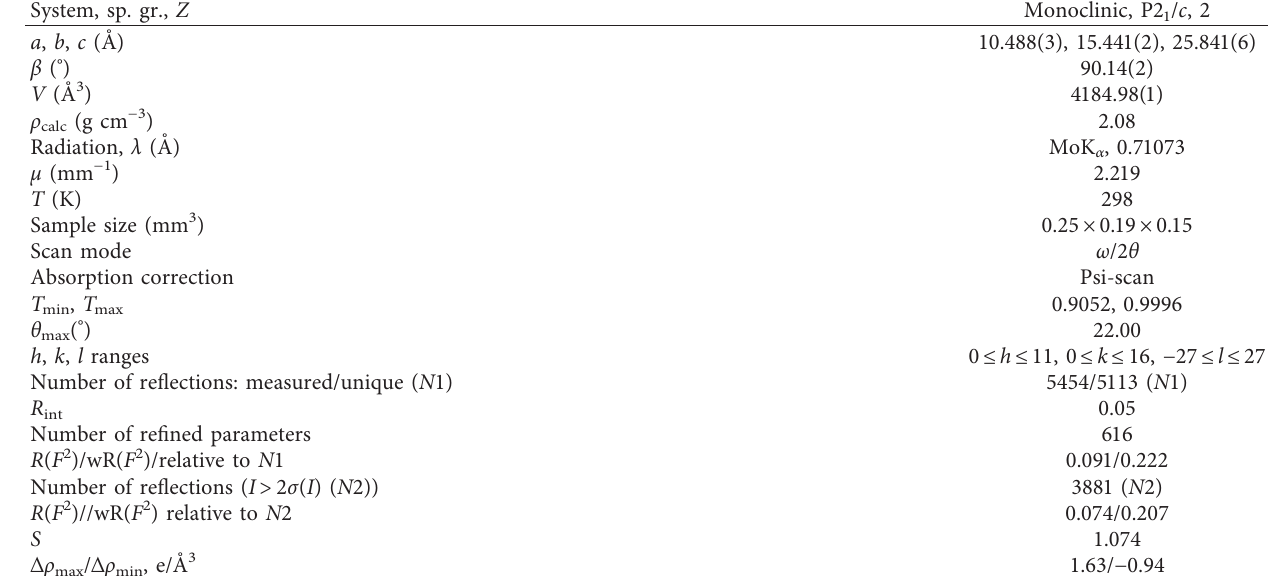
28. 4.21H 7 N 3 H 20 ) 2 V 10 O 2 O.